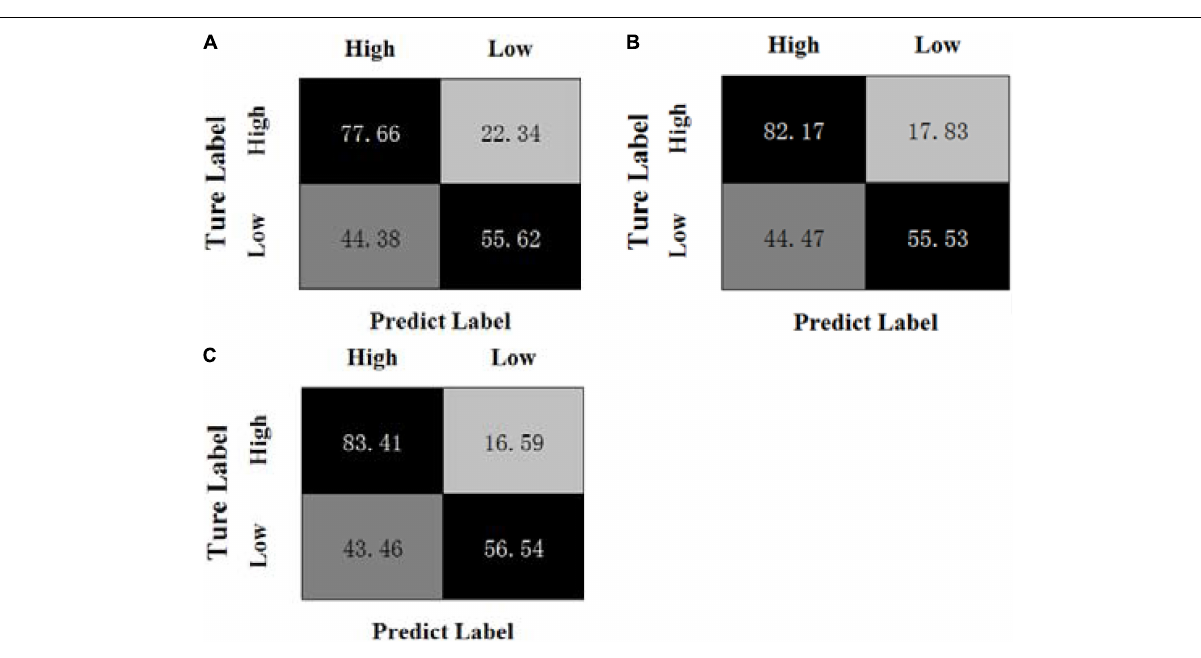
FIGURE 4 | Confusion matrices of MBCC on the DEAP dataset in valence, (A) β + γ , (B) α + β + γ , (C) θ + α + β + γ